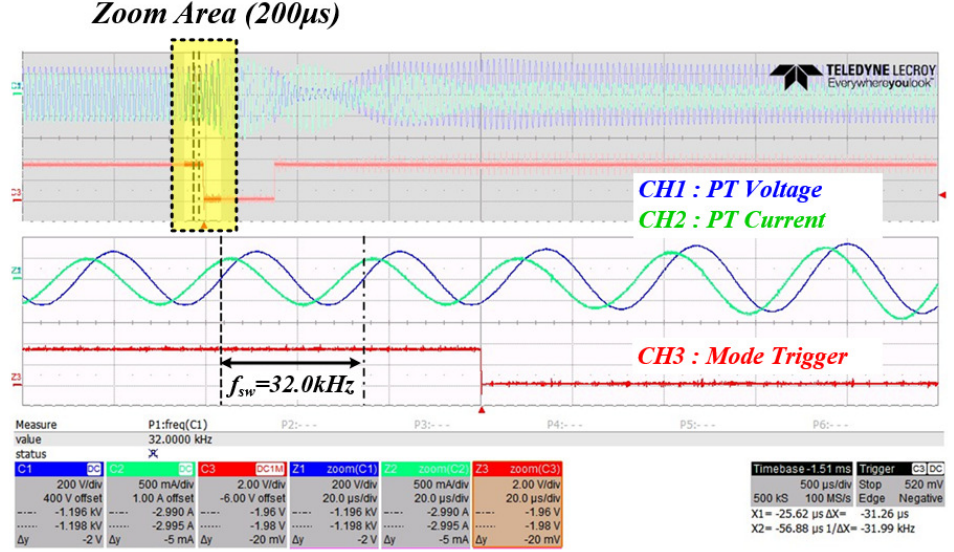
Figure 26. PT output waveform when mode 1 changes to mode 2 (CH1: PT voltage (blue), CH2: PT current (green), CH3: mode trigger